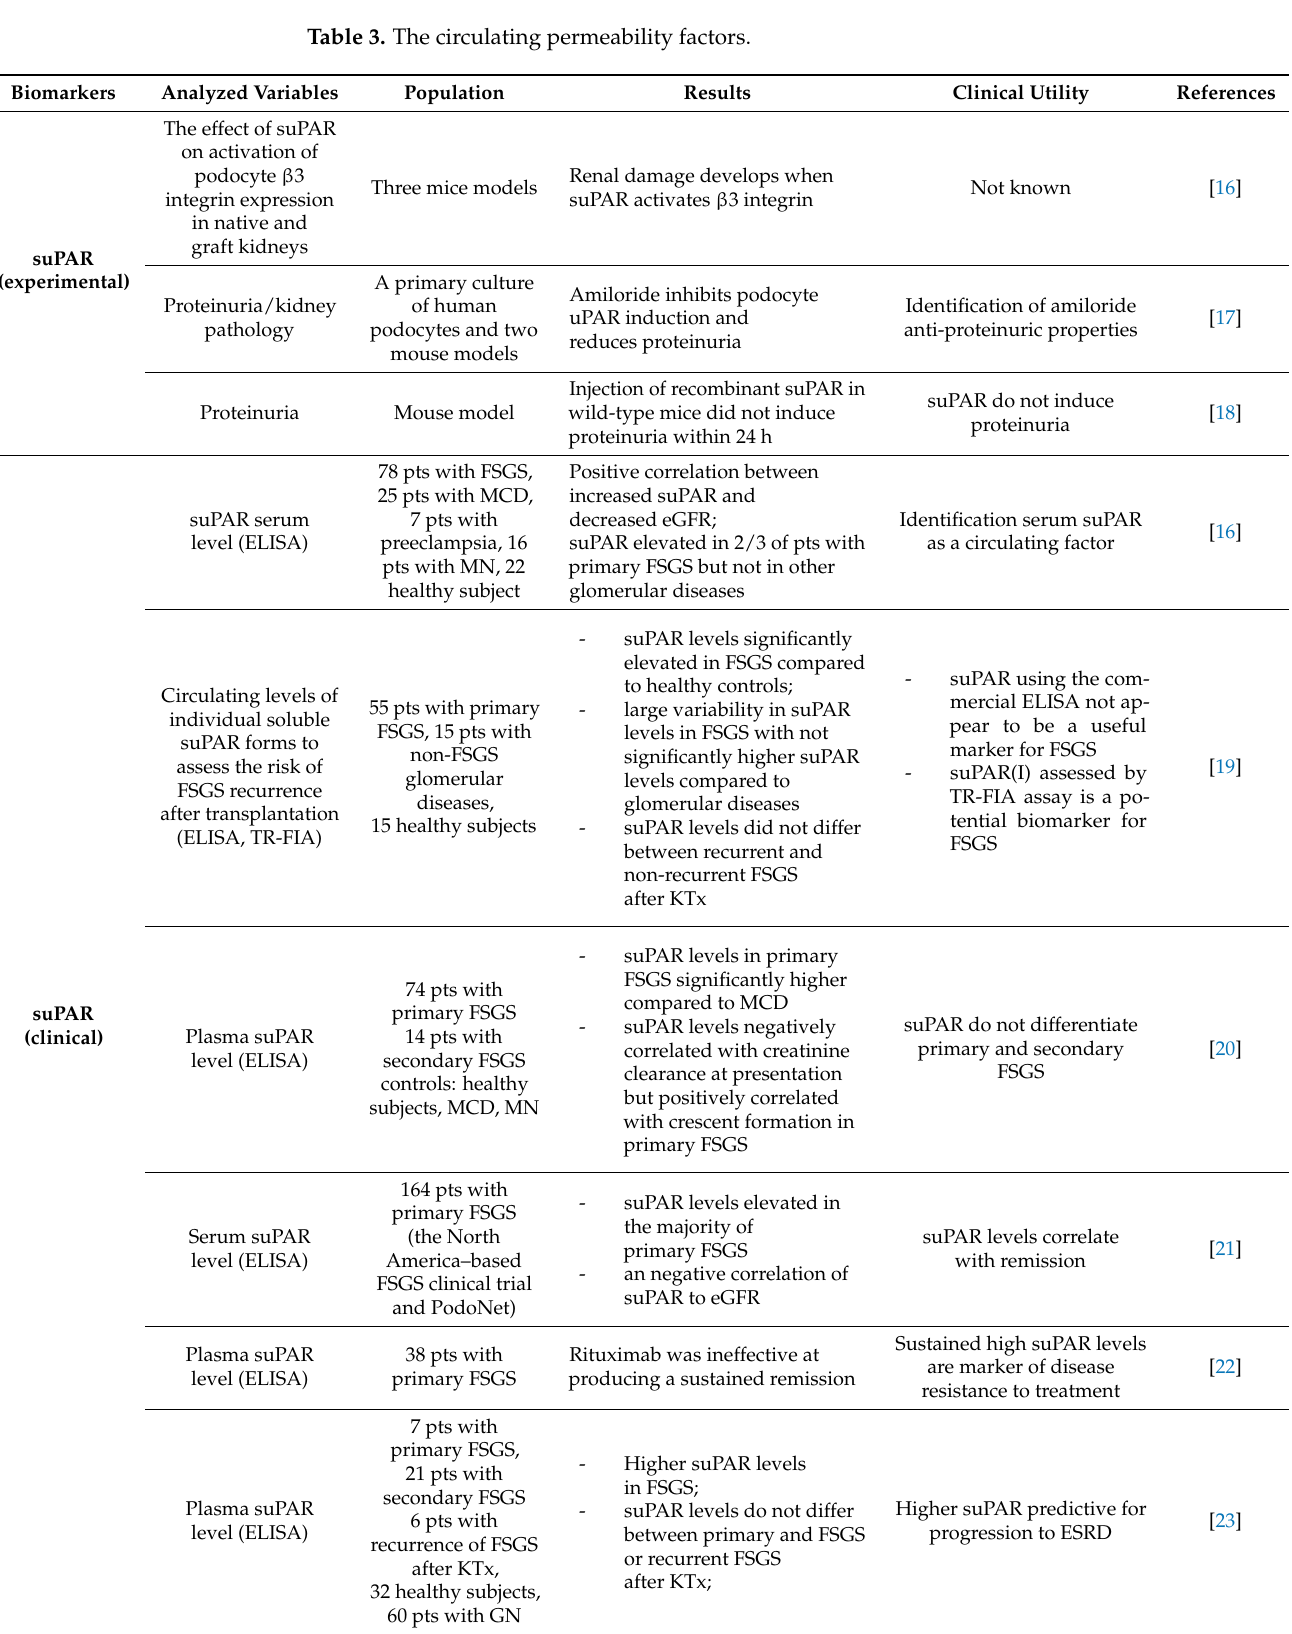
Table 3. The circulating permeability